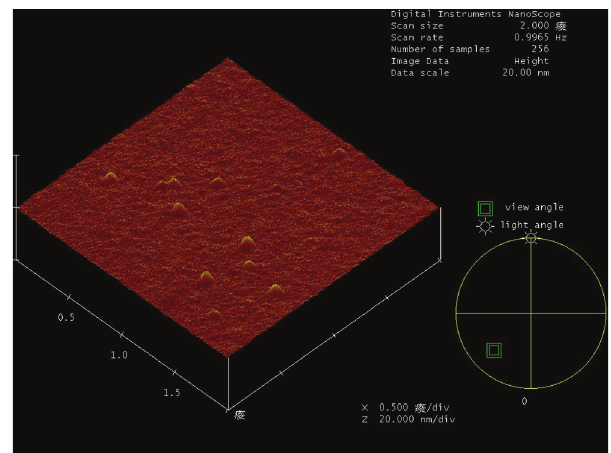
Figure 9: Surface morphology of the Ge epilayer grown at 30 mTorr. The RMS surface roughness is 0.342 nm.